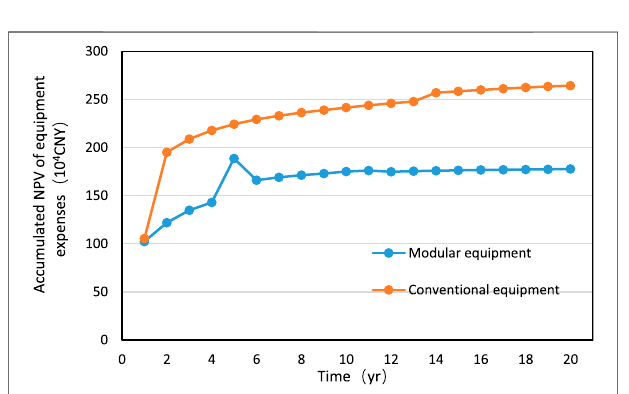
FIGURE 7 | Expenses of modular equipment and traditional fi xed